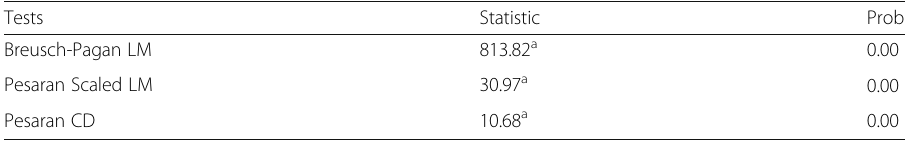
Table 9 Cross sectional dependence tests